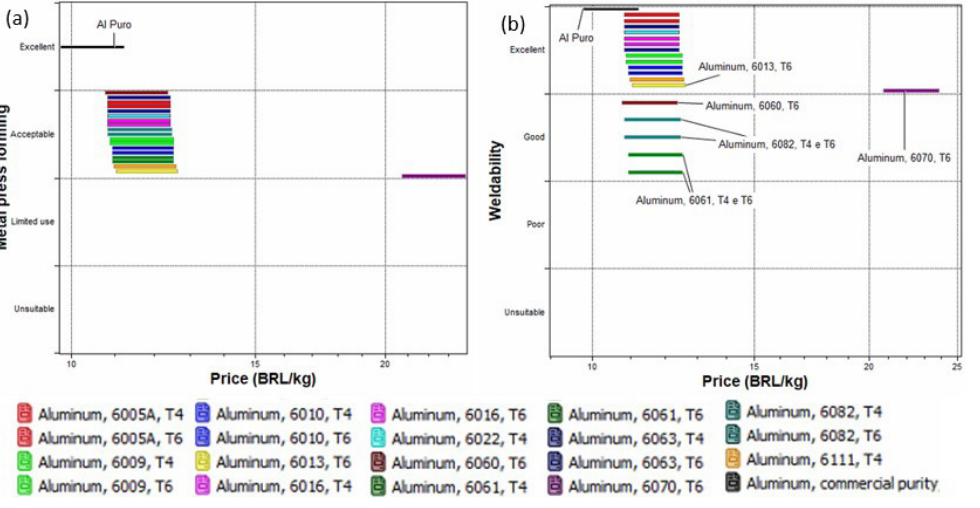
Figure 6. (a) Stampability and (b) weldability of the 6000 alloys. Images used are courtesy of ANSYS,